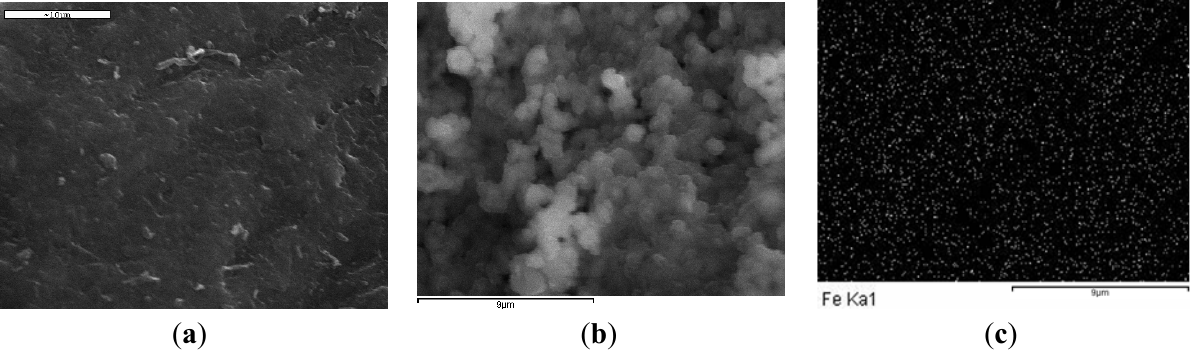
Figure 3. SEM images of: ( a ) CS; ( b ) CSm; ( c ) Fe distribution map of